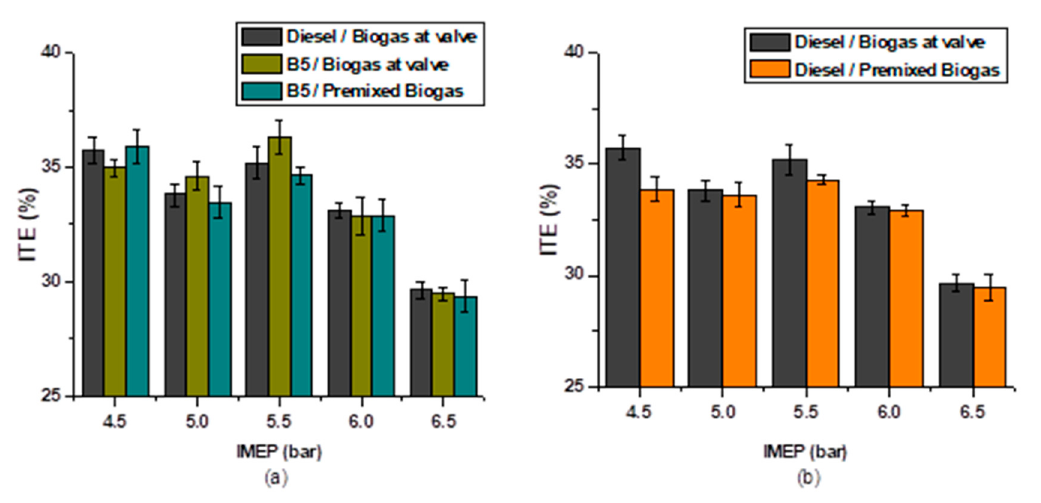
Figure 13. Variation of indicated thermal efficiency (ITE) for ( a ) B5/biogas RCCI in premixed and injection at the valve and ( b ) diesel / biogas in a premixed and port injection at the valve.